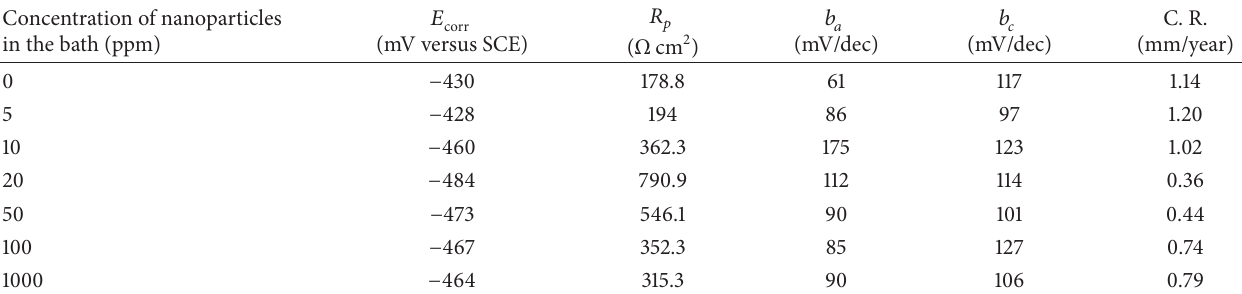
SO derived from polarization measurements. 2 4